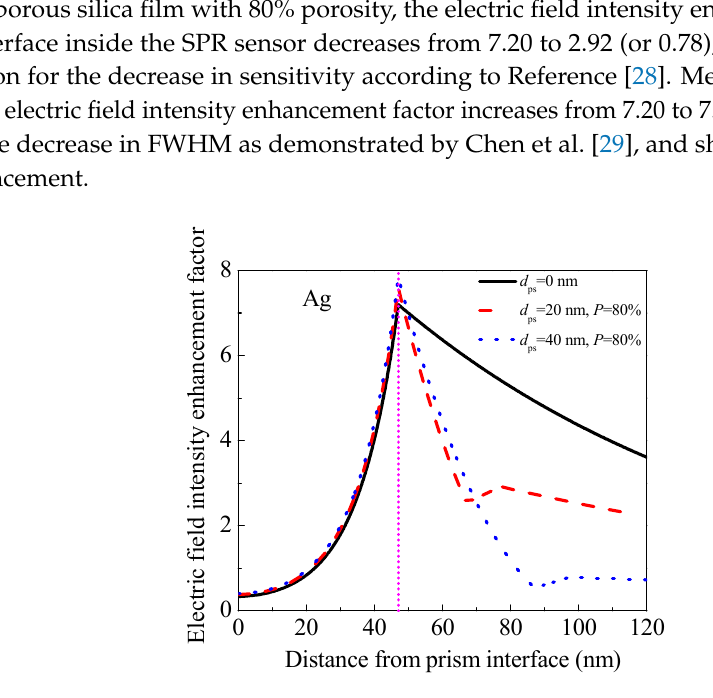
Figure 9. FOM versus the refractive index of porous silica film with various thicknesses. In Figure 9, except for the FOM curve for d ps = 0 nm (traditional SPR sensor used for comparison), other FOM curves all go up with the decreasing of the refractive index of porous silica film. This indicates that the porous silica film with a lower refractive index (i.e., higher porosity) can realize a larger FOM. In addition, the FOM enhancement can be realized when the refractive index of the porous silica film is less than a critical value for a given film thickness. The critical refractive index is 1.162, 1.202, and 1.219 for 40, 80, and 120 nm thick porous silica film, respectively. Furthermore, the FOM enhancement increases with the thickness of the low-refractive-index porous silica film. However, with the increasing of the thickness, the depth of dip also rapidly increases, which degrades the signal-to-noise of the SPR sensor [11]. Under the condition of low depth of dip ( R res < 1 × 10 −2 ), the largest FOM enhancement is achieved by adding a 40 nm thick porous silica film with 90% porosity ( n ps = 1.04) in a traditional SPR sensor, which can enhance the FOM by an increase factor of 311%. 4. Conclusions The SPR sensor with a porous silica film has been theoretically investigated in this paper. Compared with a traditional SPR sensor, the SPR sensor with a porous silica film exhibited higher FOM when the refractive index of porous silica film is less than a critical value for a given film